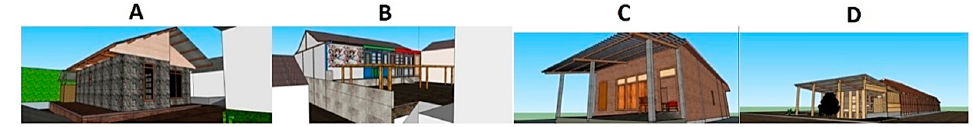
Figure 3. The sample houses: ( A ) exposed stone houses in the mountains, ( B ) wooden houses in the mountains, ( C ) exposed brick houses on beaches, and ( D ) wooden houses on beaches.